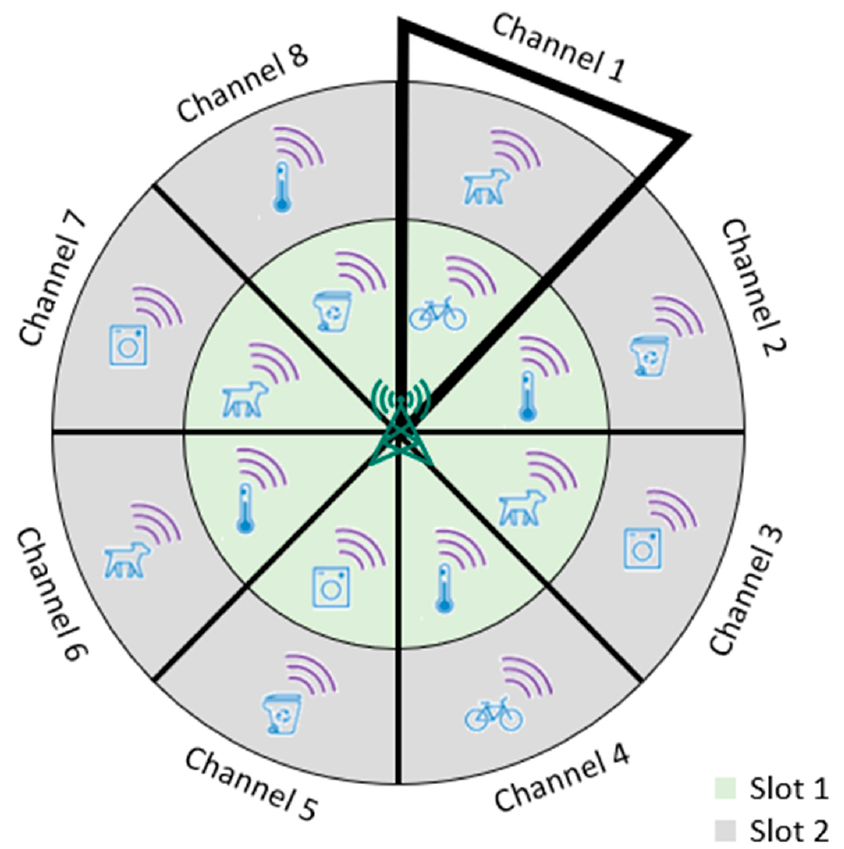
Figure 5. The basic principle of the slot- and channel-allocation protocol (SCAP). For a better understanding of the protocol operation, Figure 6 describes the workflow of the mechanisms of the slot- and channel-allocation protocol (SCAP). Accordingly, it shows the flow of each step, as described previously, in SCAP in order to send a packet. Moreover, Algorithm 1 shows the algorithm sequence of the slot- and channel-allocation protocol